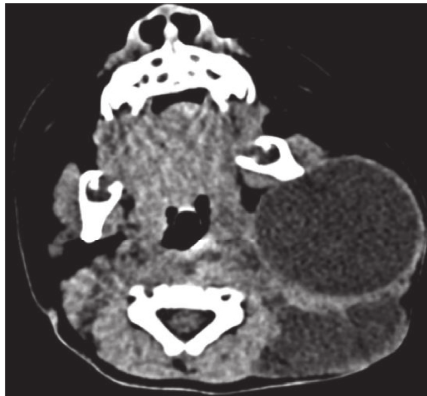
Figure 2: Axial computed tomography showing left cervical cystic hygroma.